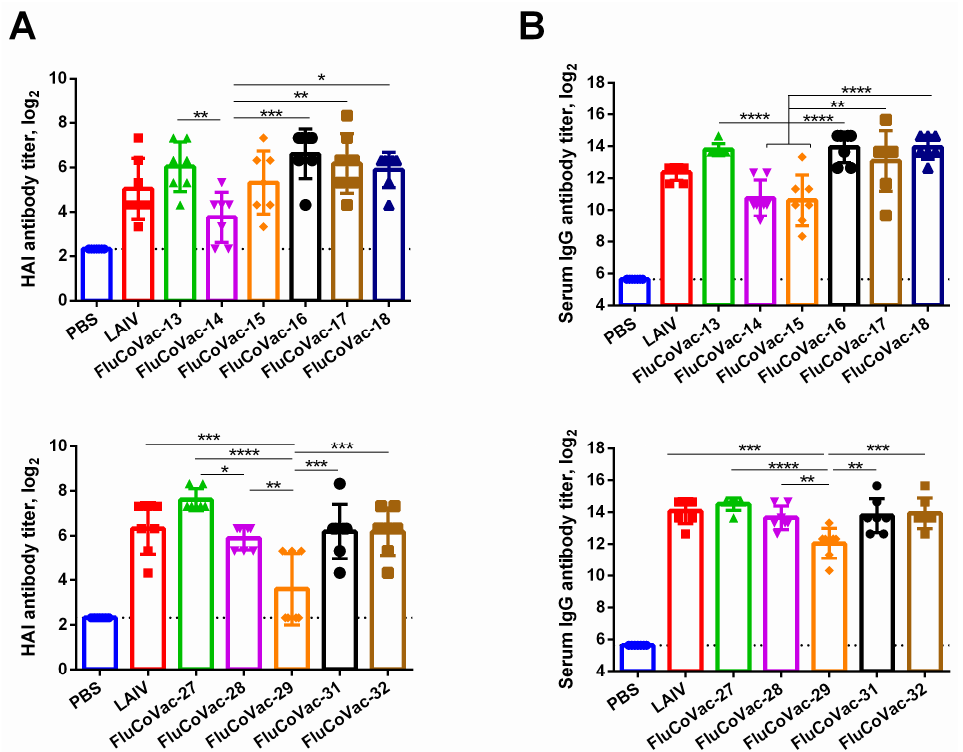
Figure 3. Antibody responses to the whole influenza virus in HLA-A2.1 transgenic mice immunized with studied recombinant LAIV viruses. Mice were i.n. inoculated twice with 10 6 EID 50 of each test virus within a 3-week interval. On day 10 post second dose serum samples ( n = 7) were collected and influenza virus-specific antibody were assessed by ( A ) HAI assay and ( B ) ELISA to the whole influenza virus antigen. Upper and lower panels demonstrate the results of experiment #1 and #2, respectively. Data were analyzed by one-way ANOVA with Tukey’s post-hoc multiple analyses test. *— p < 0.05; **— p < 0.01; ***— p < 0.001; ****— p < 0.0001